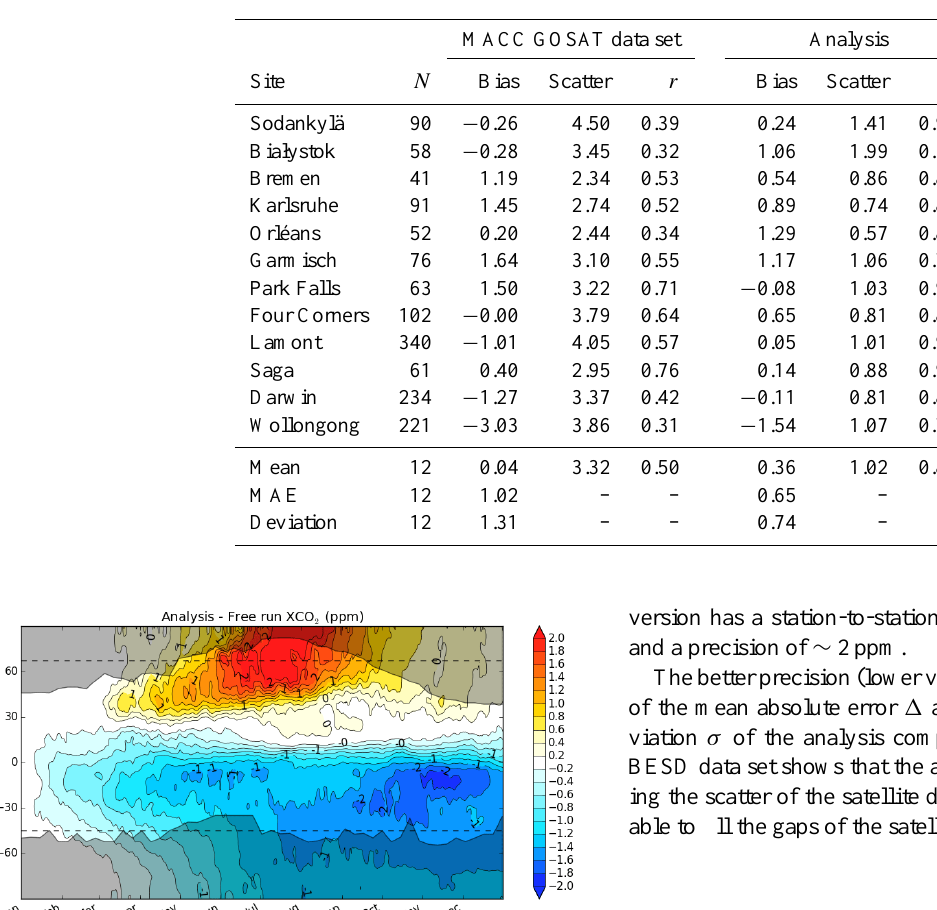
Table 3. Statistics of the XCO 2 differences between the MACC GOSAT BESD data set and the average hourly TCCON data (left block, GOSAT–TCCON) or the analysis and the average hourly TCCON data (right block, model–TCCON): bias ( δ k , in ppm), scatter ( σ k , in ppm) and correlation coefficient ( r k ). The analysis has been sampled similarly to the GOSAT data set in time and space. Also shown are the mean, the mean absolute error (MAE) and the deviation of the stations bias, the mean scatter (all in ppm) and the mean r (last three rows). The second column ( N ) is the number of data points used for computing the statistics.